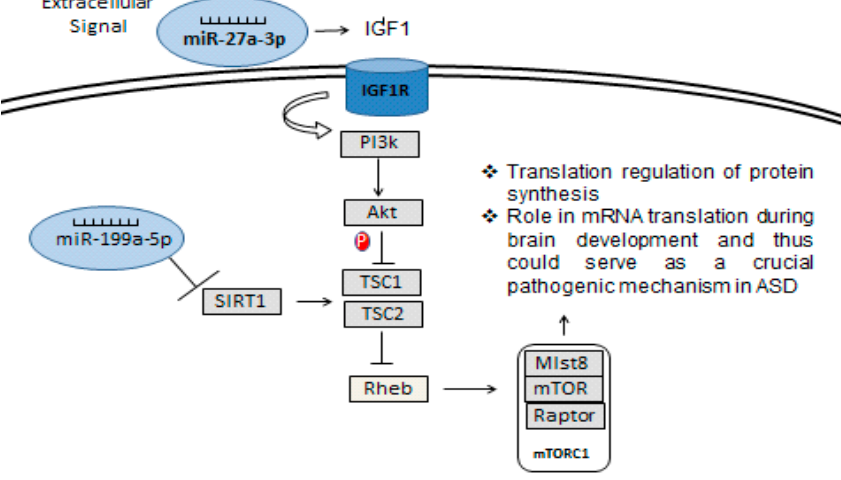
Figure 8. miRNA regulatory pathway in the control of the protein synthesis through SIRT1—TSC:mTOR.